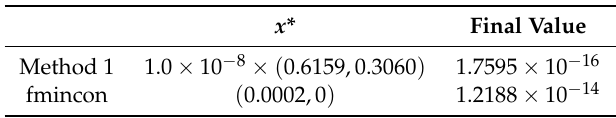
Table 2. Numerical results for Example 1 by Method 1 and fmincon.